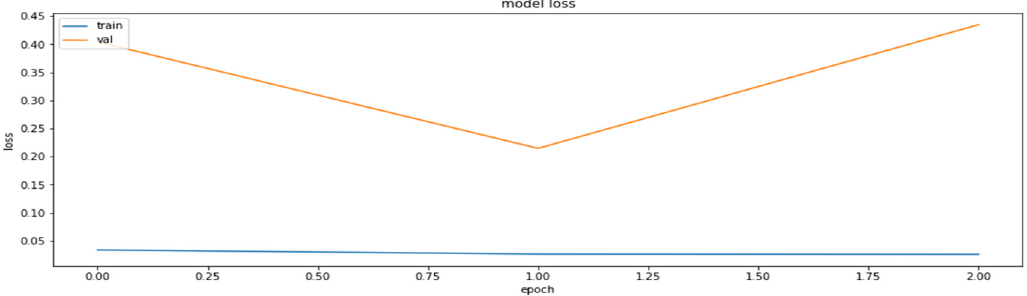
Figure 9. Training and the validation datasets obtained during the implementation of the weight clustering of the PCQAT.